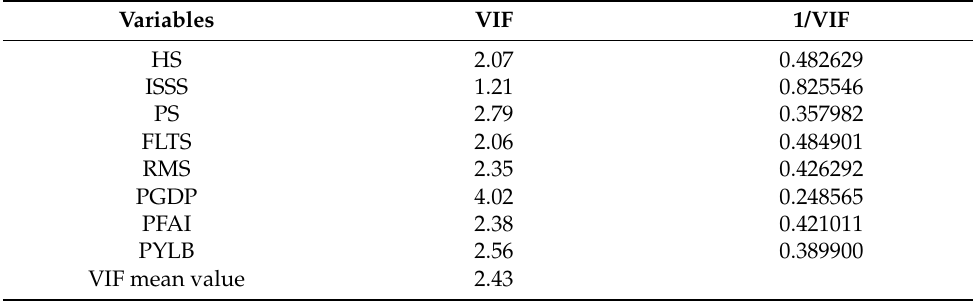
Table 5. Multicollinearity